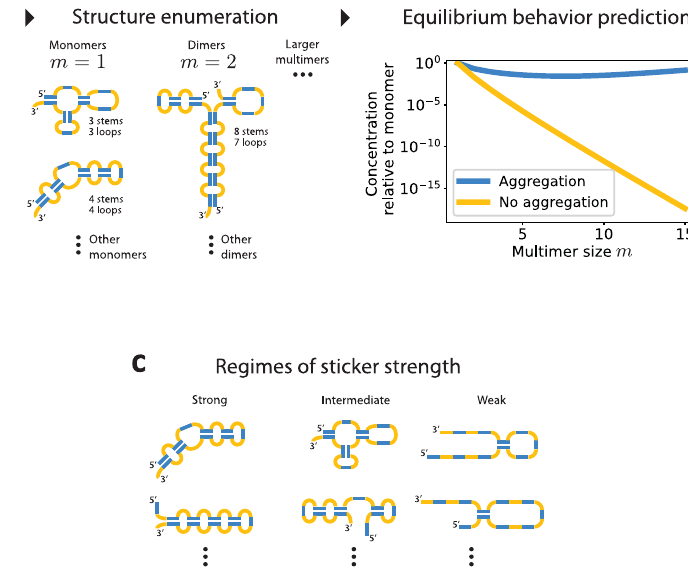
Fig. 1 | Model overview. a Model procedure : A repeat RNA or DNA sequence is converted to a sticker-spacer model, with stickers comprised of self- complementary regions. Possible structures, including multimers, are then enum- erated by either computational or analytical methods. Partition functions are then calculated, leading to a complete description of the equilibrium behavior of the system,includingtheequilibriumconcentrationsofmultimers.Thesystemisinthe aggregation regime when concentrations remain constant or increase with multi- mer size. b Regimes of linker length : The system can exhibit qualitatively different